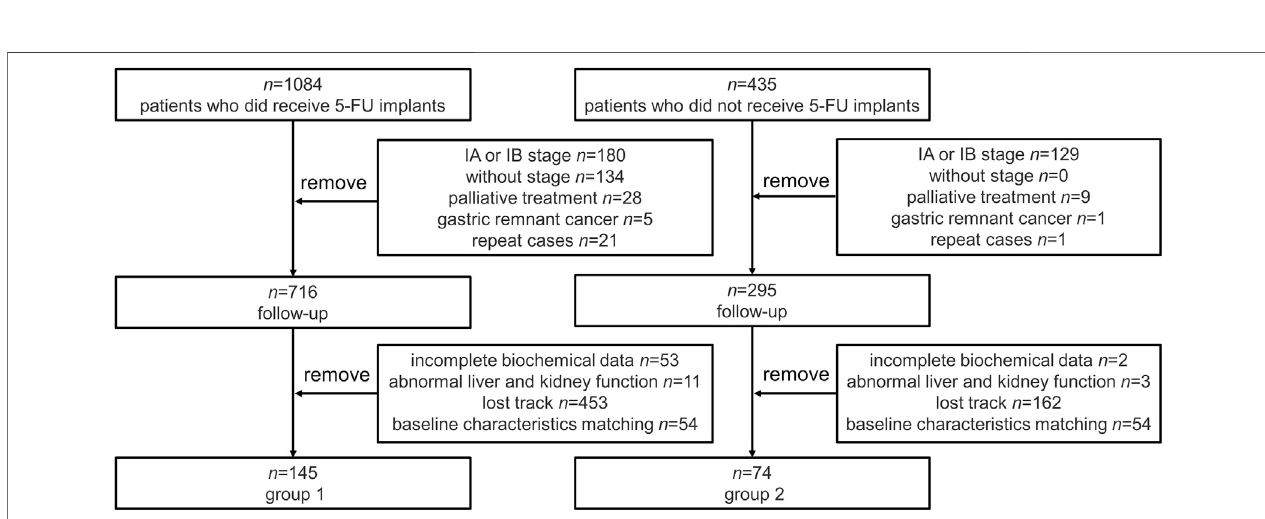
FIGURE 2 | Flowchart of the selection of included patients. Repeat cases: The exactly same cases during the retrieval of patient data. 5-FU, 5- fl uorouracil.